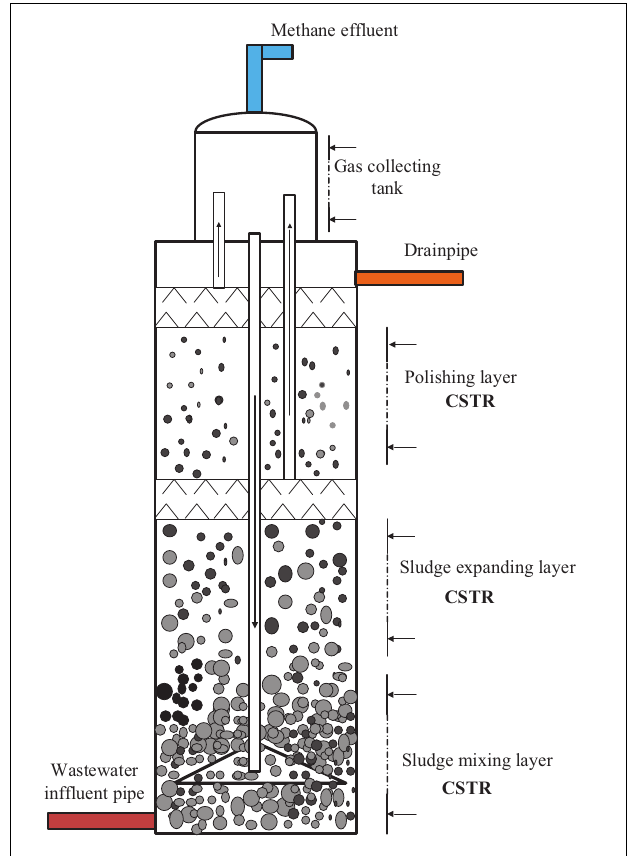
FIGURE 1 | Schematic diagram of three CSTRs in series simulating hydrodynamic of full-scale IC reactor.